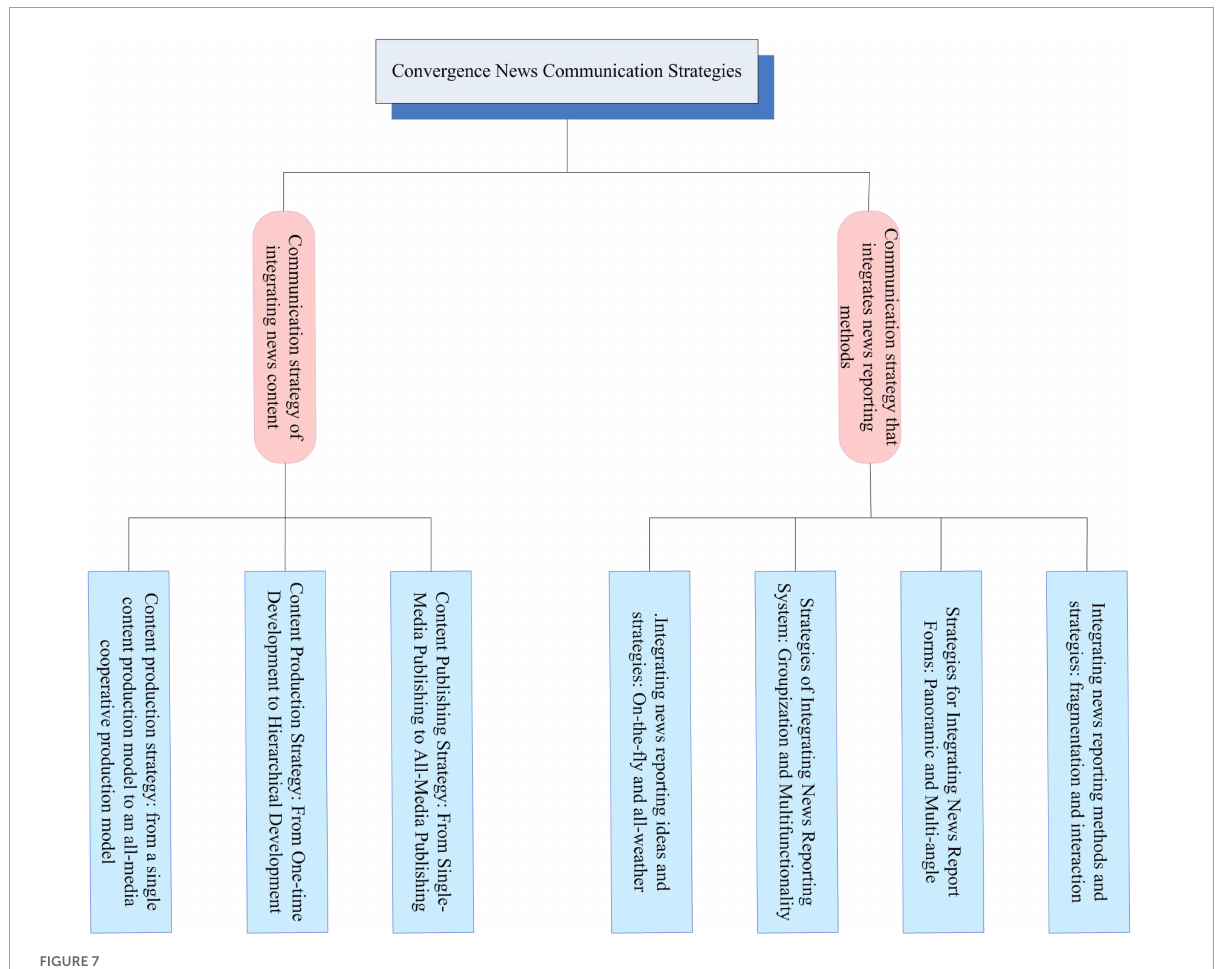
FIGURE7 Communication strategies for convergent